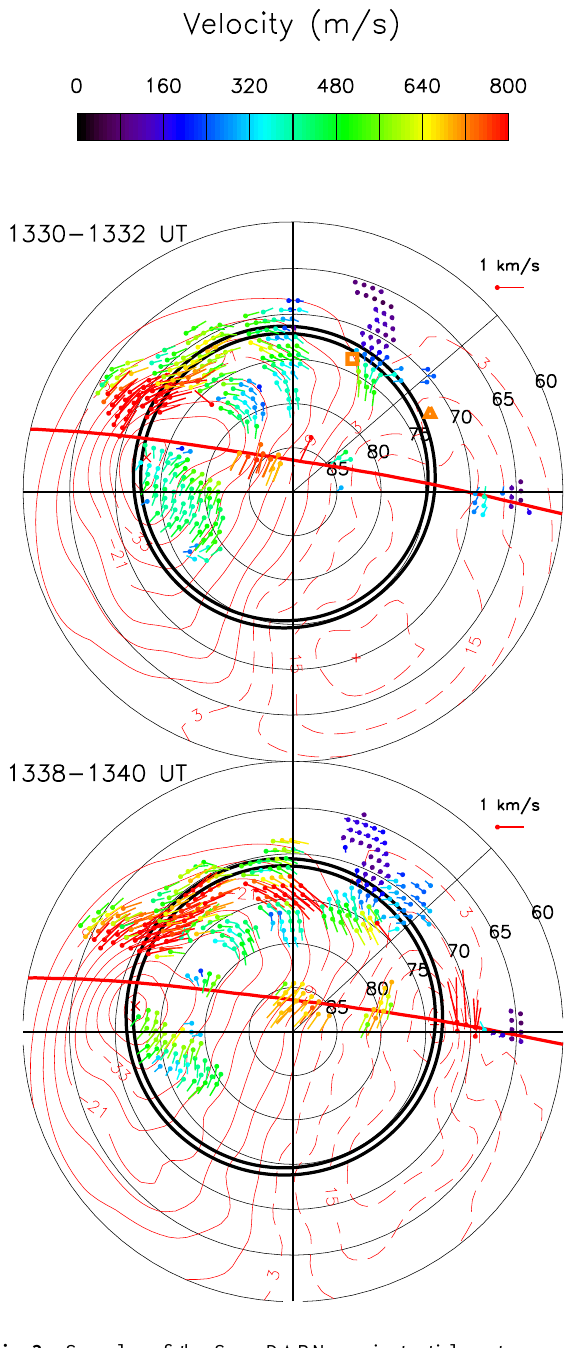
Fig. 3. Samples of the SuperDARN equipotential contour maps for two periods, with radar determined “true vectors” and satellite plasma drift vectors overlaid, both colour-coded according to mag- nitude. The path of the DMSP F13 satellite in the interval from 13:24 to 13:38 UT is shown by the red line. The orange square and triangle in Fig. 3a mark the location to which the Equator-S and Geotail satellites map at 13:30 UT, respectively. The longitude line in the upper right quadrant of each picture marks the 0 ◦ E